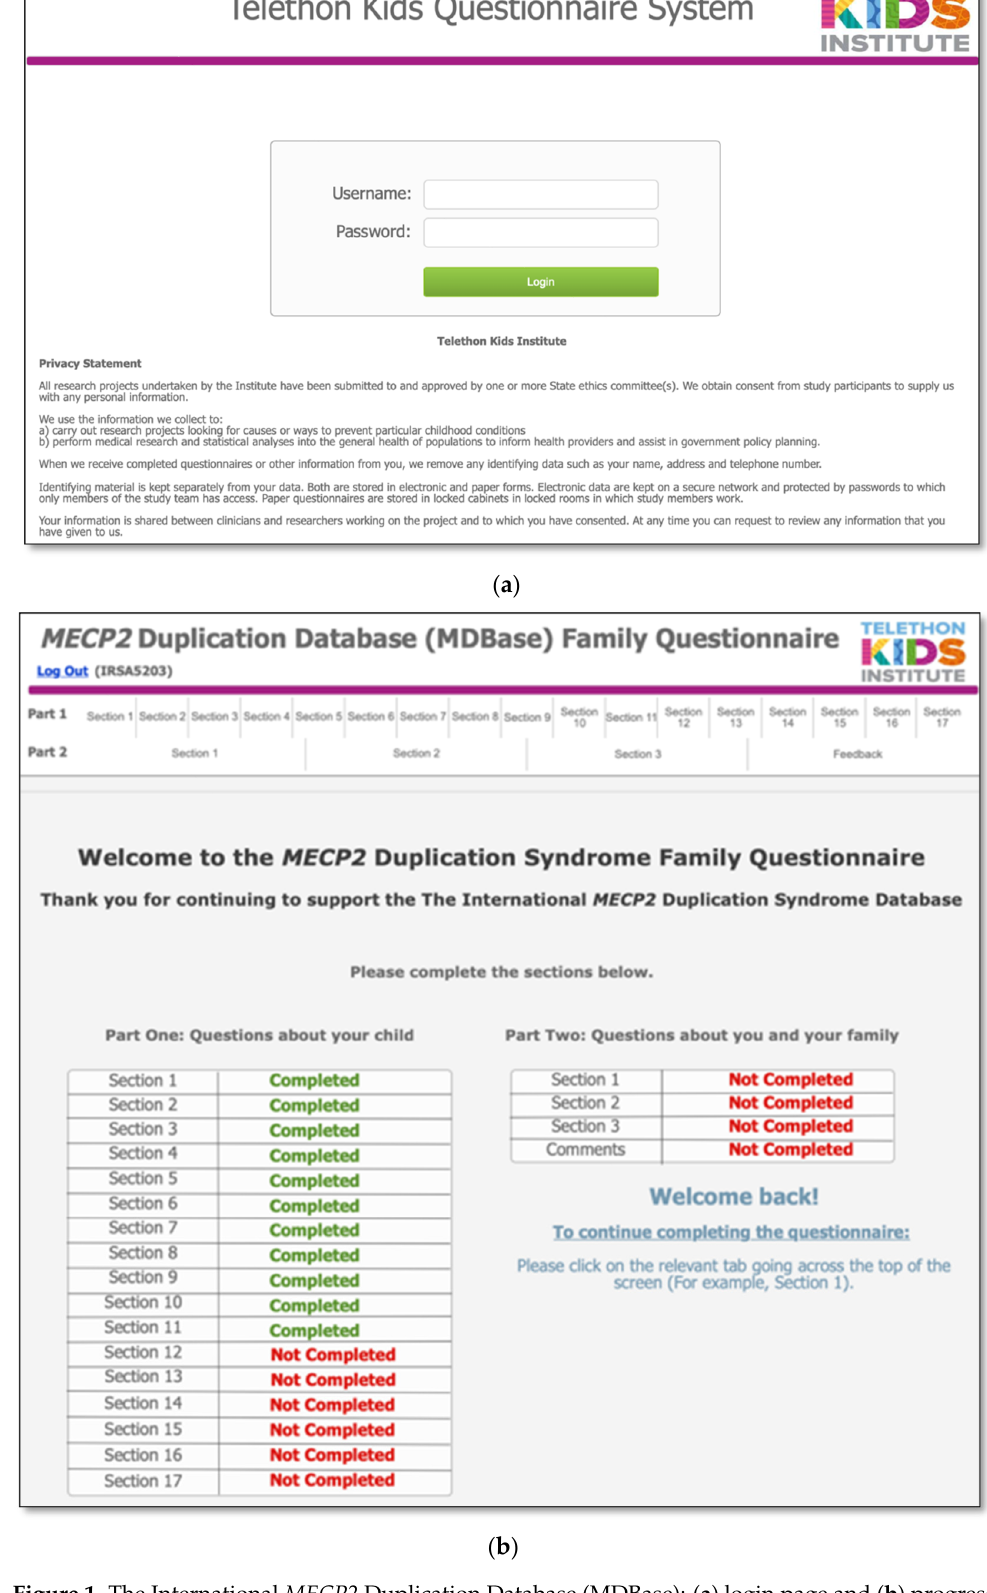
Figure 1. The International MECP2 Duplication Database (MDBase): ( a ) login page and ( b ) progress status page.